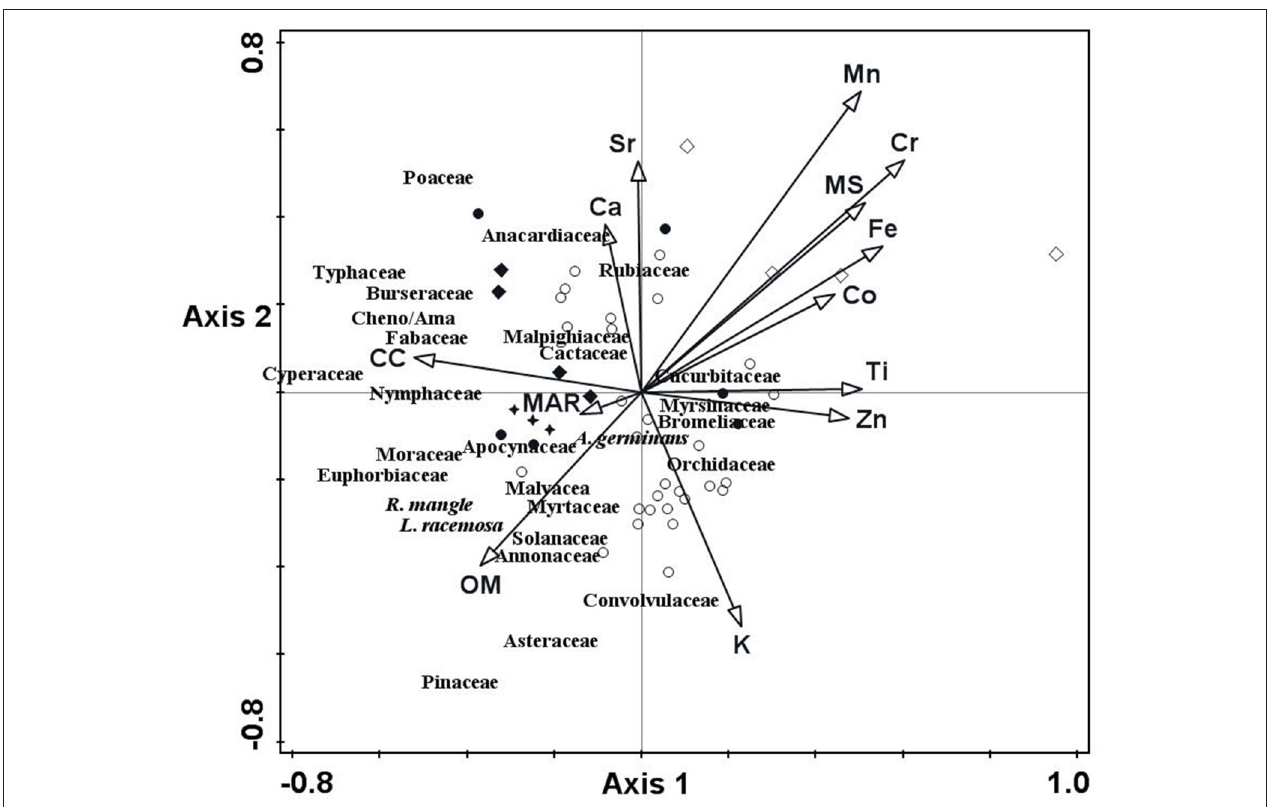
FIGURE 7 | Redundancy analysis triplot showing the relationship between pollen taxa composition with chemical element composition, Organic matter (OM), Carbonate Content (CC), Magnetic susceptibility (MS), and Mass Accumulation Rate (MAR). The different symbols represent ordination scores. They represent ages in calibrated years AD. Ages in black open circles correspond with the Little Ice Age; in black circles to ages previous to the MCA; in open black diamonds to the Medieval Climate Anomaly; in filled black diamonds to the Spanish Occupation and in black stars to the Manzanillo port opening and the tsunami of